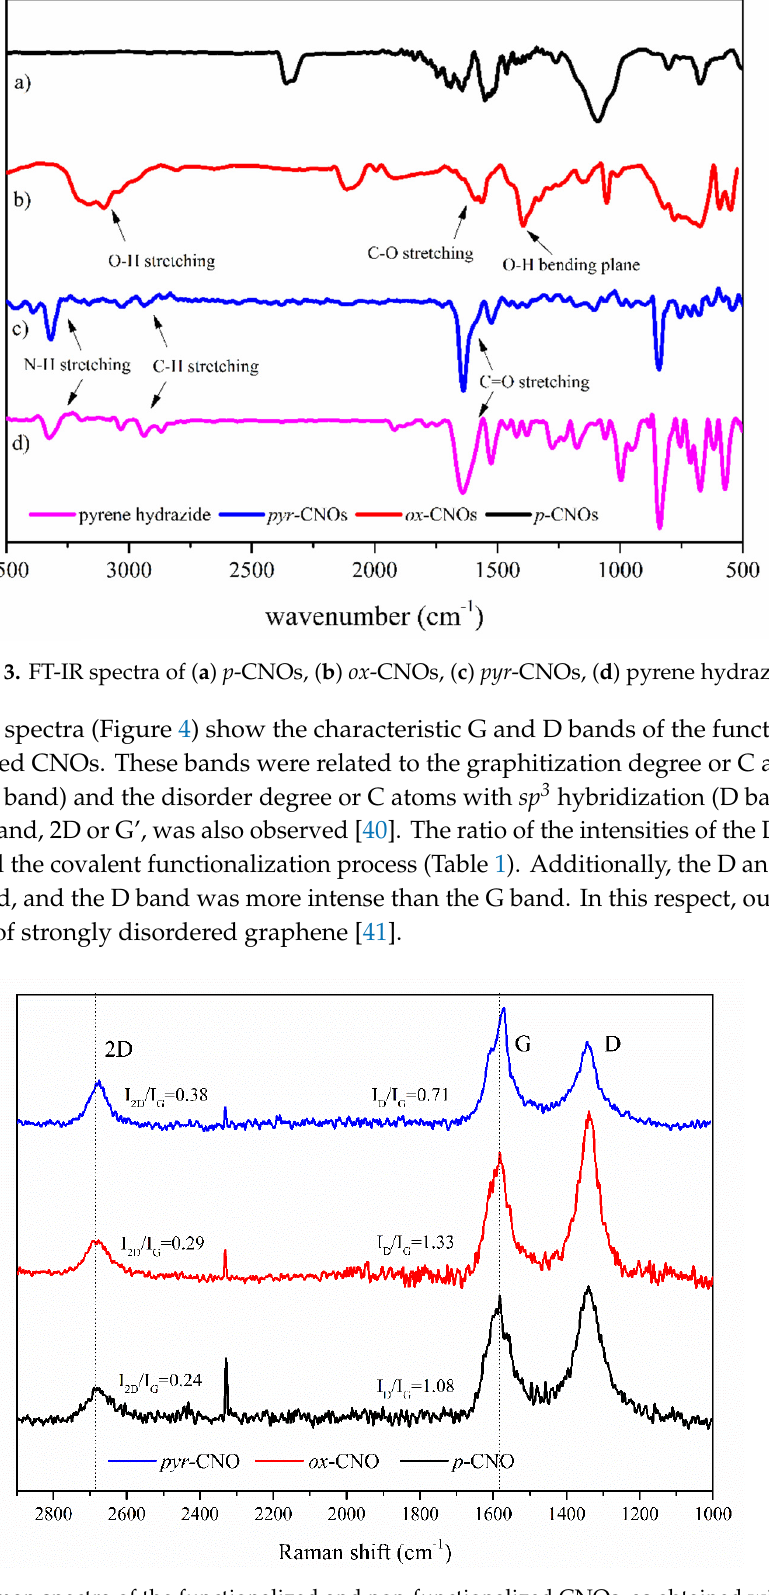
Figure 4. Raman spectra of the functionalized and non-functionalized CNOs, as obtained with 532 nm laser excitation. Table 1. D and G band intensity ratios of the functionalized and non-functionalized CNOs.